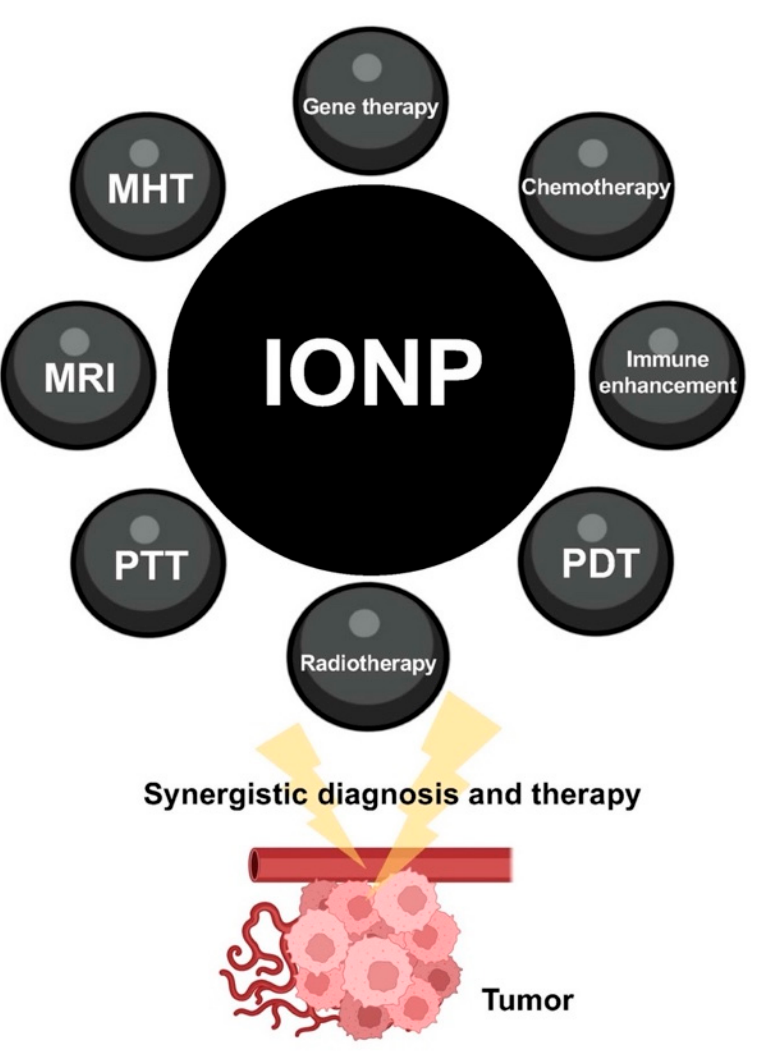
Figure 2. Gene therapy combining with other strategies to synergistically play a role in the diagnosis and treatment of tumors based on the versatility of IONPs.